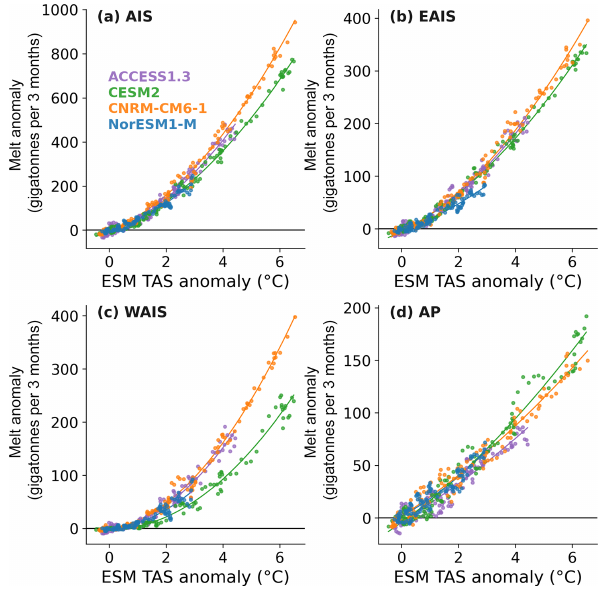
Figure 2. Mean summer melt changes (gigatonnes per 3 months) projected by MAR forced by ACCESS1.3 (purple), CESM2 (green), CNRM-CM6-1 (orange), and NorESM1-M (blue) for all the Antarctic ice shelves (a) , the ice shelves of the East Antarctic sector (b) , the West Antarctic sector (c) , and the Antarctic Penin- sula (d) compared to mean summer ESM near-surface temperature ( ◦ C) over 90–60 ◦